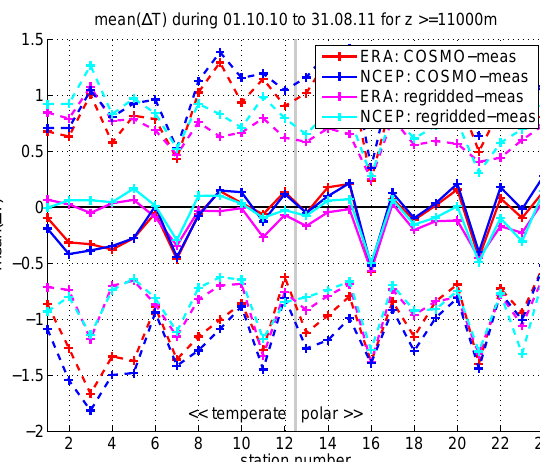
Figure 8. Mean difference in temperature over all heights (top) and heights with z ≥ 11km (bottom) for each station. The dashed line corresponds in color to the full line which is always half the standard deviation of the difference above and below the mean value. See Table B1 for a list of the stations corresponding to the